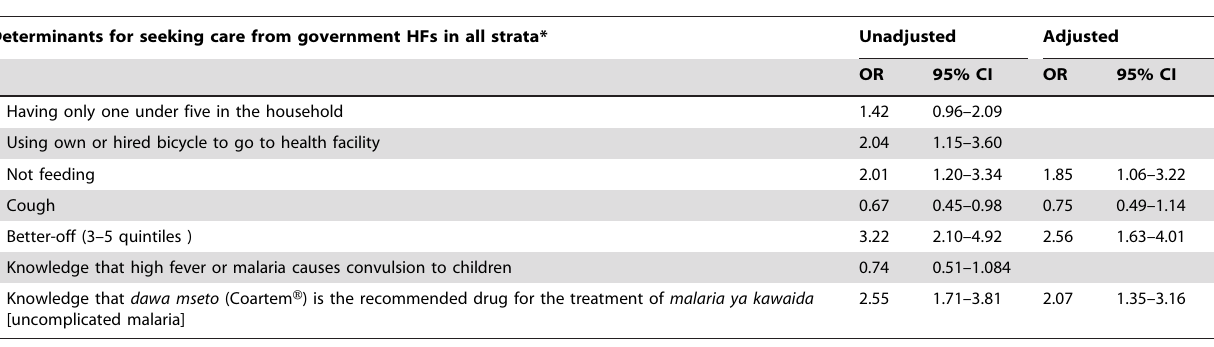
Table 3. Determinants of seeking care from government facilities for children under five reported to have fever in Kilosa district.